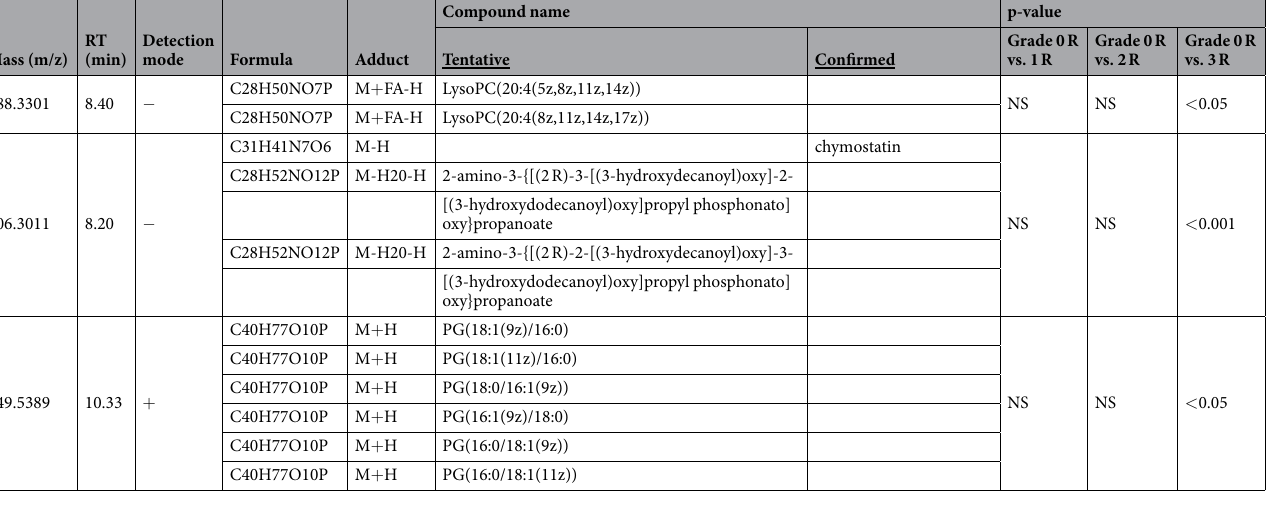
Table 2. Metabolomics identifies differential metabolites between patients without allograft rejection